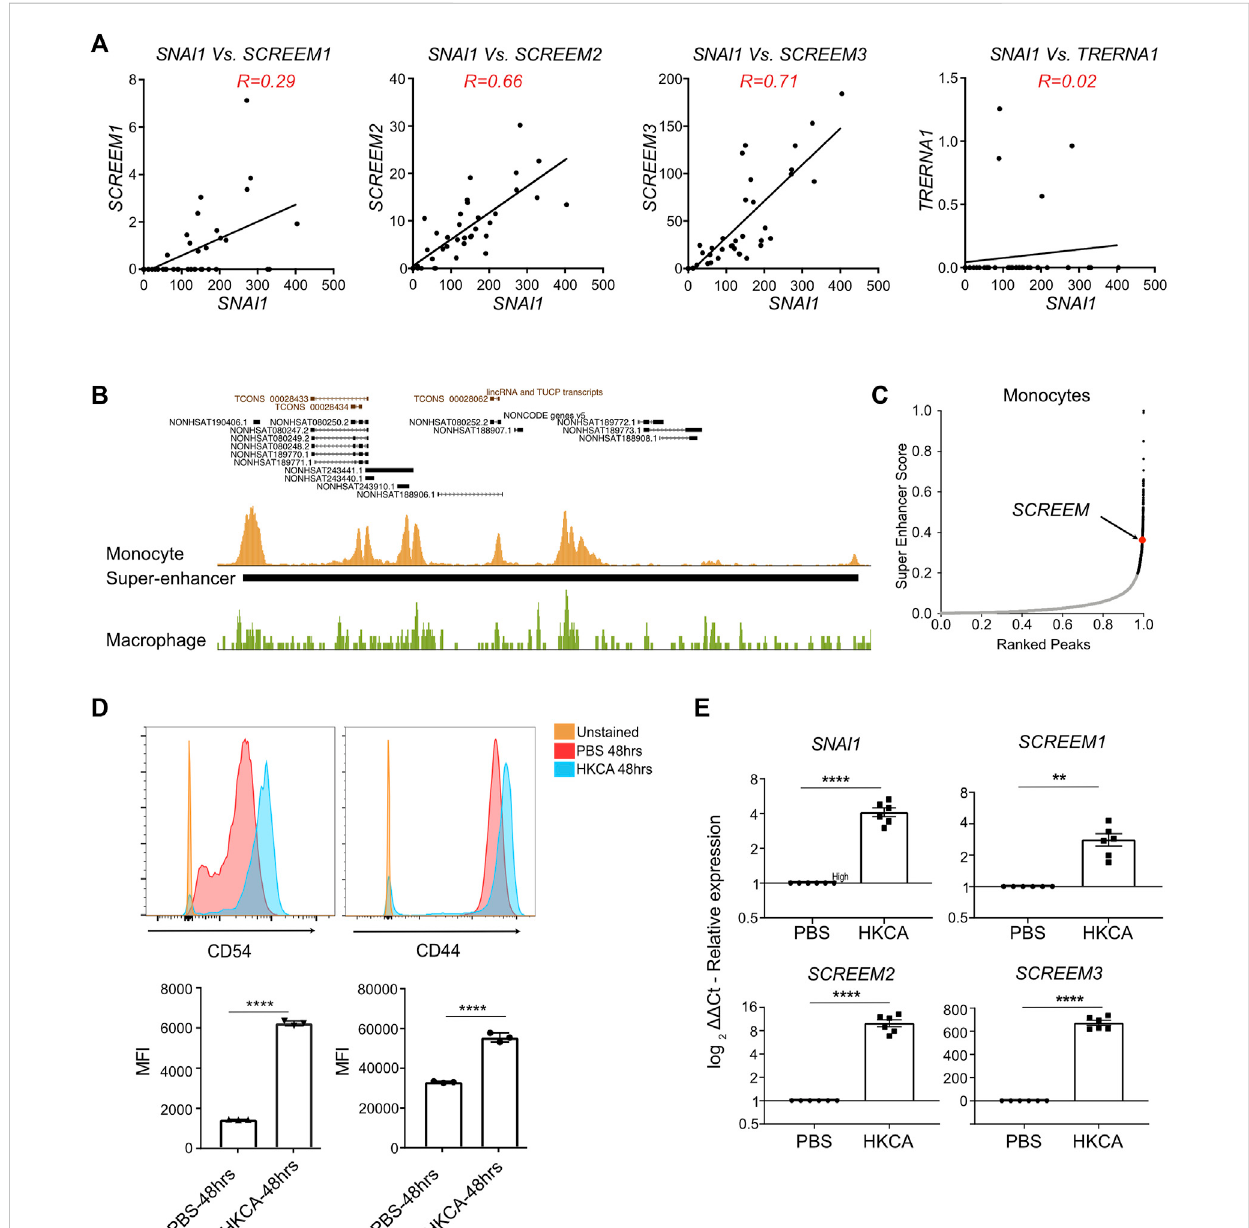
Monocytes stimulated with C. albicans express SNAI1 enhancer eRNAs and SNAI1. (A) Normalized CAGE counts mapped to the 5 ′ cap of SNAI1 , SCREEM1 , SCREEM2 , and SCREEM3, and TRERNA1 (counts shown were extracted from all monocyte samples in FANTOM5). R values were calculated using simple linear regression. (B) A UCSC genome browser view of the SCREEM loci and proximal genes is shown on top. Peaks of H3K27ac from ChIP- Seq data from monocytes (gold) a macrophages (green) is show below. The solid back bar shows the position of a region annotated as a super- enhancerbytheHOMERpipeline. (C) Plotsshowingmonocyteenhancersrankedbysuper-enhancerscore.Super-enhancers(asde fi nedbywhereslope is greater than 1) are indicated by black dots. The position of the SCREEM super-enhancer is annotated in red. (D) On top are representative fl ow cytometric plots of CD54 (left) and CD44 (right) expression on monocytes exposed to HKCA or PBS for 48 h. Below shows quanti fi cation of mean fl uorescence intensity (MFI) of CD54 and CD44 staining. Plotted values are mean ± SD with n = 3, biological triplicates. Statistics, unpaired t -test, **** p < 0.0001. (E) RT-PCR analysis of SCREEM1 , SCREEM2 , and SCREEM3 and SNAI1 expression in monocytes exposed to HKCA or PBS for 48 h. Plotted are delta-delta Ct values relative to mock and EMC7; NT, Non-targeting. All values are mean ± SD with n = 6, independent donors. Statistics, unpaired t -test, **** p < 0.0001, ** p <